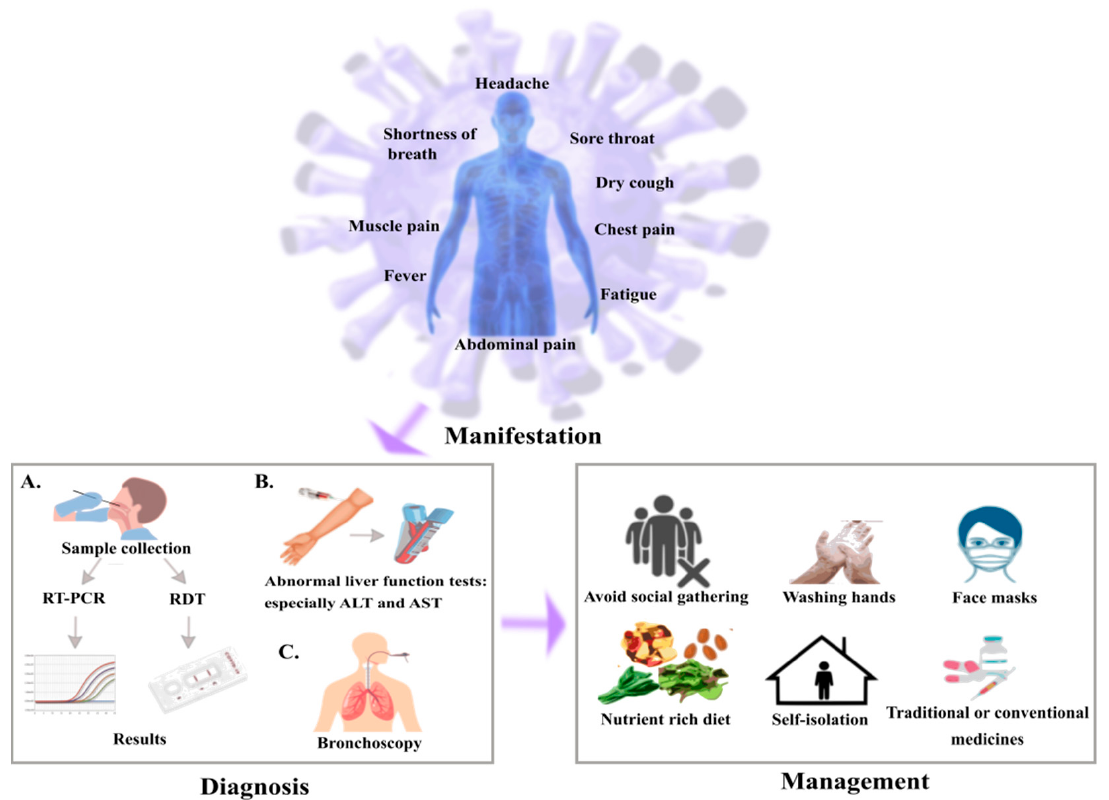
Figure 2. Illustration of scheme for SARS-CoV-2 in cancer patients. Common symptoms observed for the cancer patients with SARS-CoV-2 are fever, dry cough, fatigue, dyspnea. In diagnosis, ( A ) sample has been collected from throat or nasopharynx using sterile swabs followed by gene amplification and genetic analysis through RT-PCR or rapid diagnostic test (RDT), ( B ) abnormal liver function tests result in elevated levels of alanine aminotransferase (ALT) and aspartate aminotransferase (AST), ( C ) bronchoscopy is performed to avoid complications. In the management, cancer patients need to be more cautious compared to the normal people by restricting social meetings, maintaining good hygiene and self- isolation to avoid becoming infected and intake of medicines as prescribed by doctors.